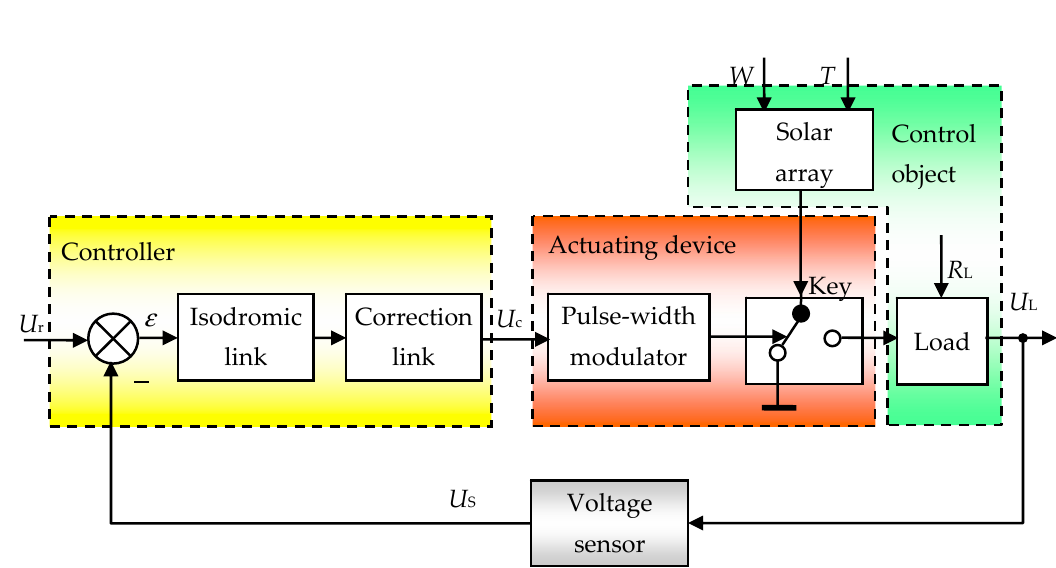
Figure 1. The structure of the solar array control system.